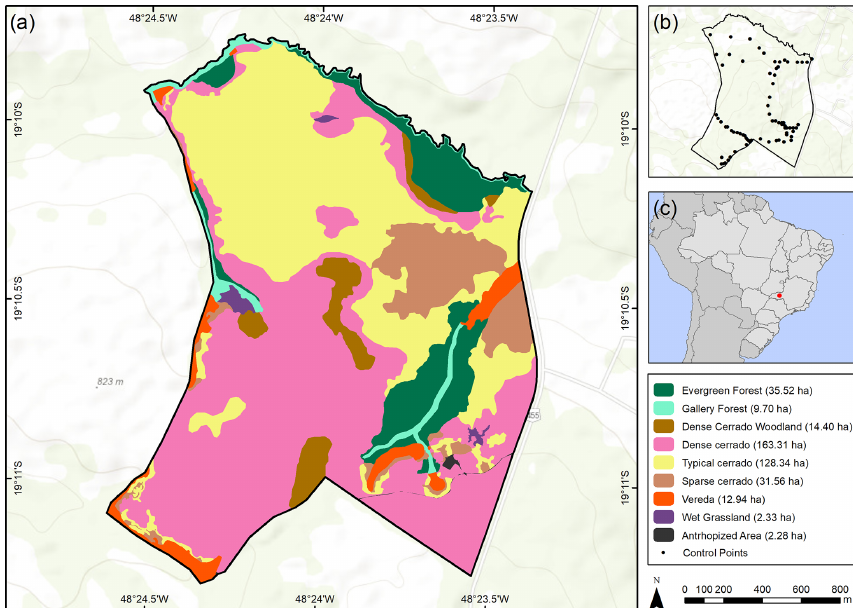
Figure 5. Occurrence of plant formation types in the PES. (a) Map of plant formations based on photo interpretation and fieldwork; (b) con- trol points marked during fieldwork; and (c) location of the studied area in